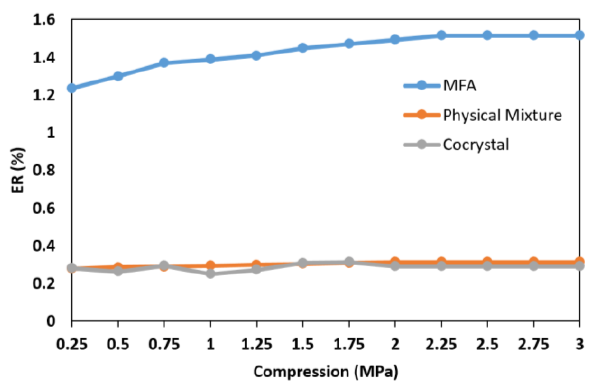
Fig. 4. The elastic recovery result of MFA, MFA-NIC physical mixture and